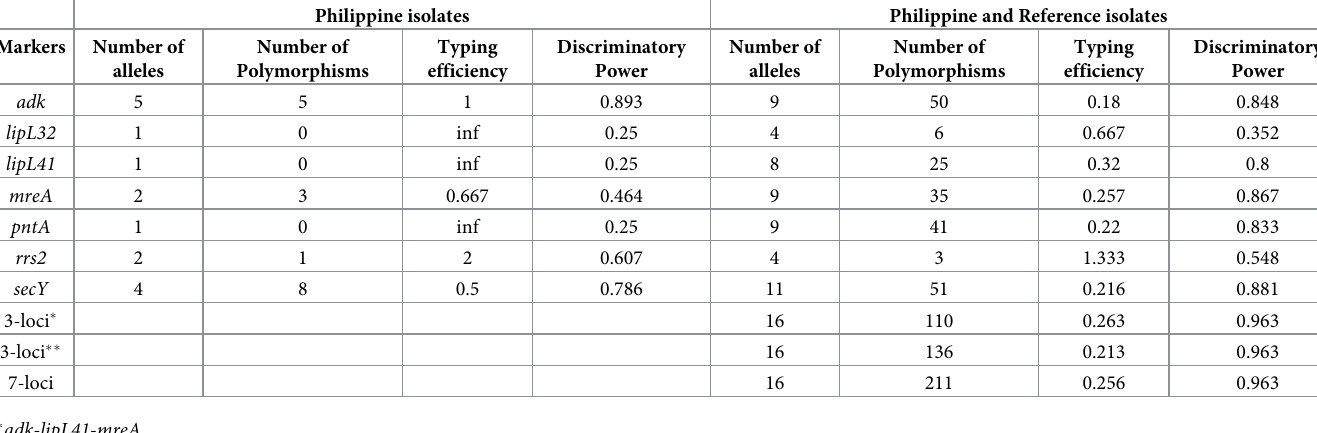
Table 2. Typing efficiency and discriminatory power of the markers analyzed for the reduced MLST scheme